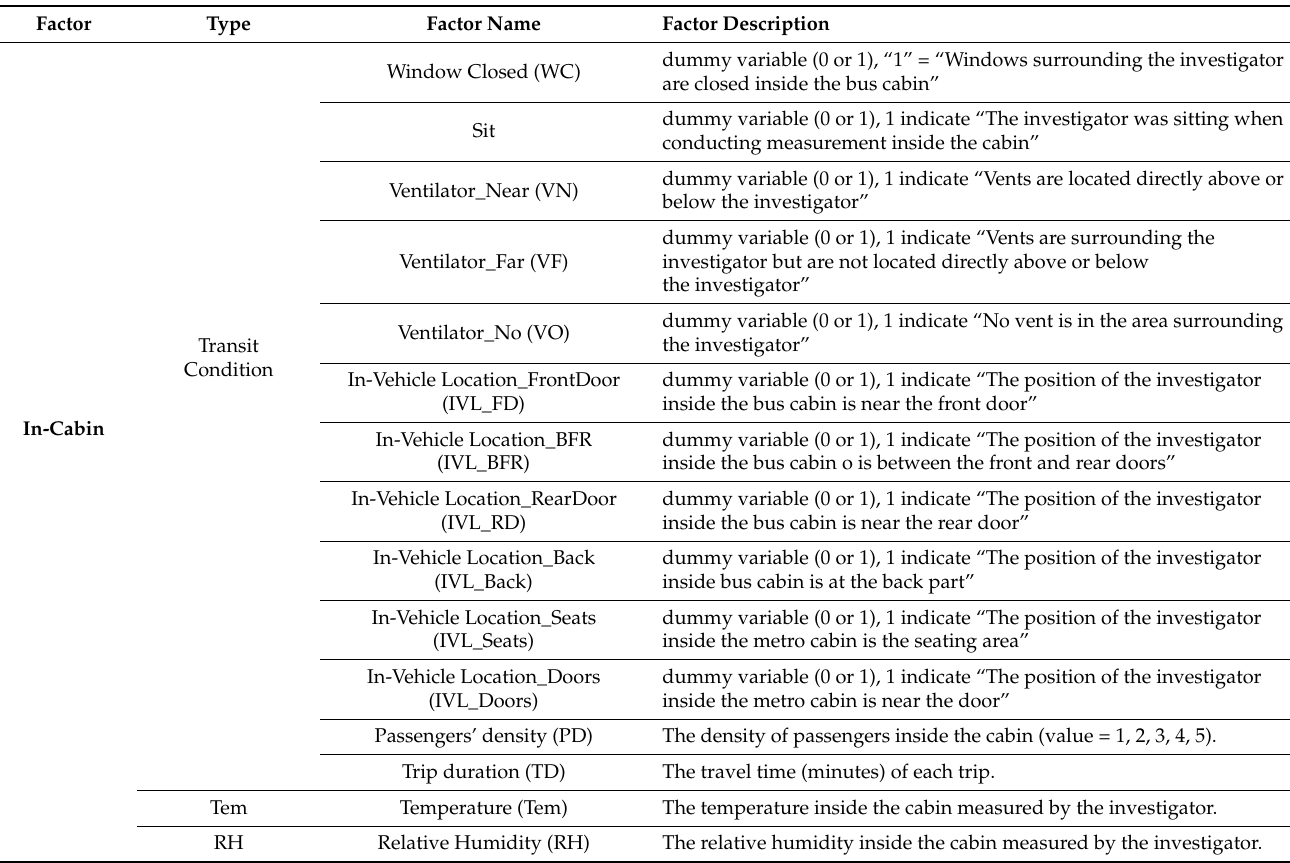
Table 1. Description of en-route environmental